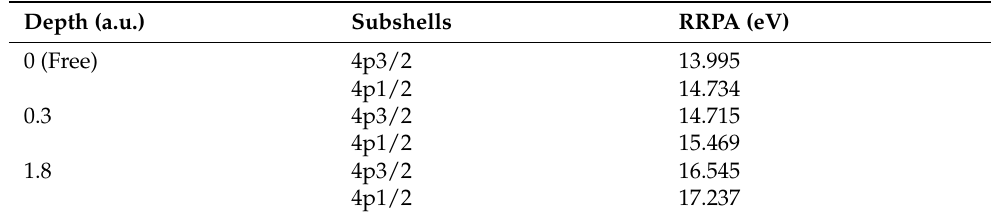
Table 2. The 4p subshell thresholds of free and confined Kr. Depth (a.u.) Figure 6: The large component of 4p 1/2 radial wavefunction of free and confined Kr .